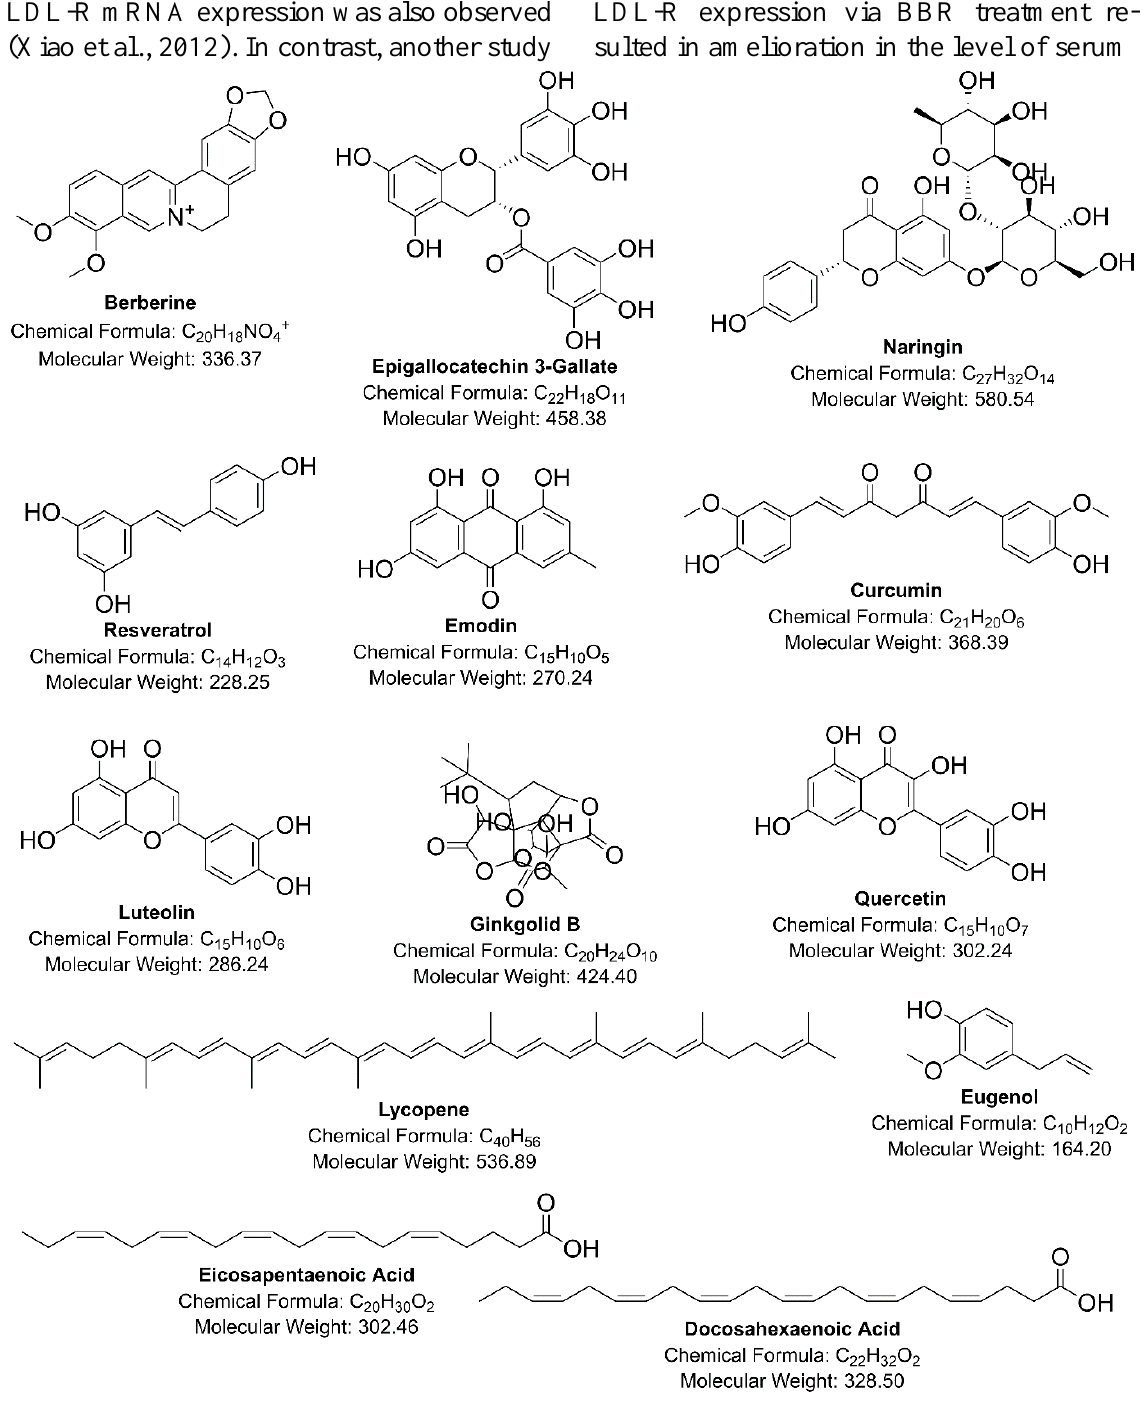
Figure 2: Chemical structures of natural inhibitors of PCSK-9 and